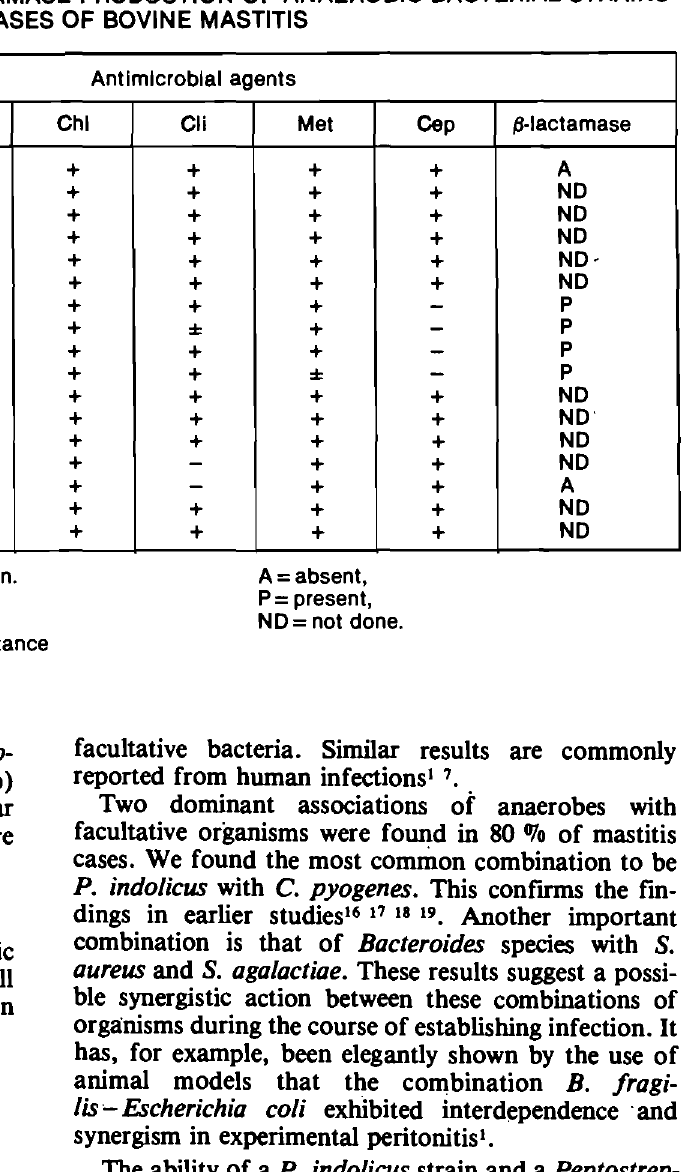
Table 4: ANTIMICROBIAL SENSITIVITY AND I3·LACTAMASE PRODUCTION OF ANAEROBIC BACTERIAL STRAINS ISOLATED FROM CASES OF BOVINE